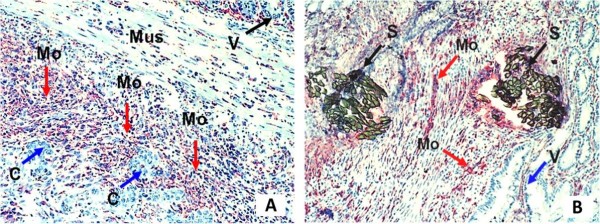
Intestinal anastomosis performed in cancer and normal tissue. (A) Cancer-colonized tissue, and (B) normal intestinal tissue, stained with anti-ED1-specific antibody for macrophages. Original magnification × 100. C, cancer islands; Mo, mononuclear cells (macrophages); Mus, muscularis mucosa; S, Suture; V, villi.